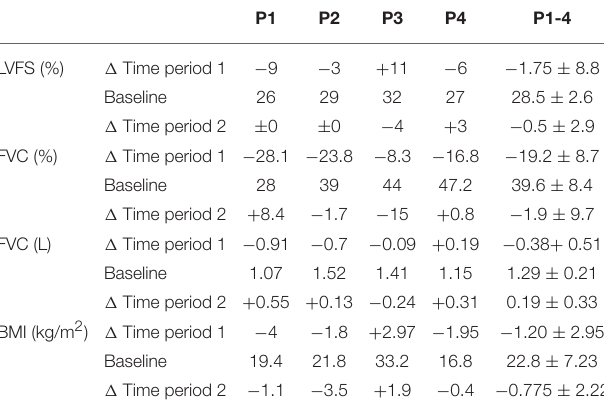
TABLE 1 | Delta changes in LVFS [%], FVC [%], FVC [L] and BMI [kg/m 2 ]. P1 P2 P3 P4